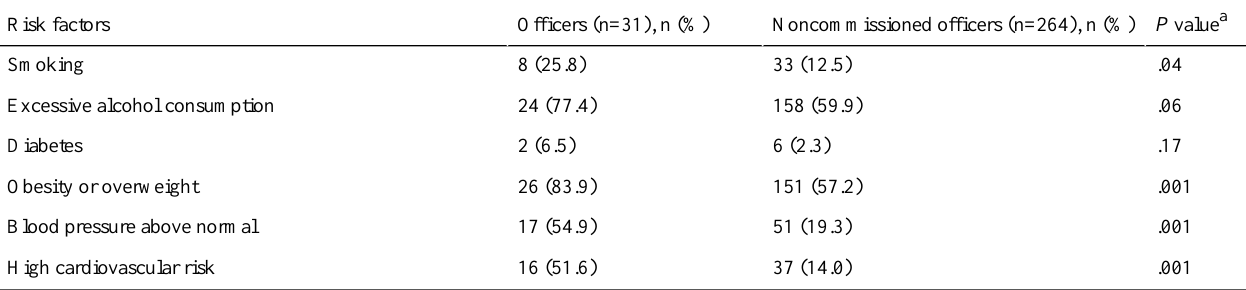
Table 5. Distribution of cardiovascular risk factors in the military